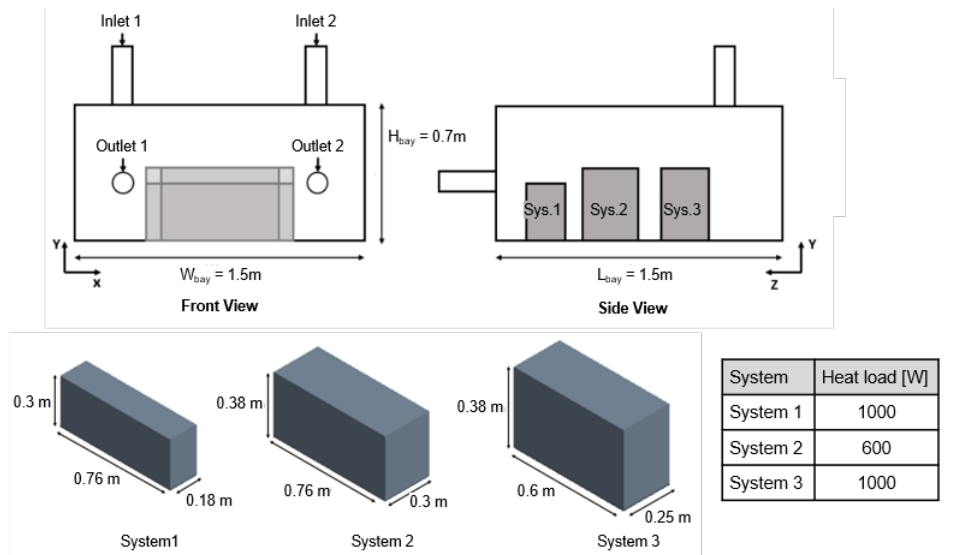
Figure 3. Simplified cockpit underfloor equipment bay with dimensions and air-inlet and outlet locations (Sys1, Sys2, and Sys3 refer to System 1, System 2, and System 3).